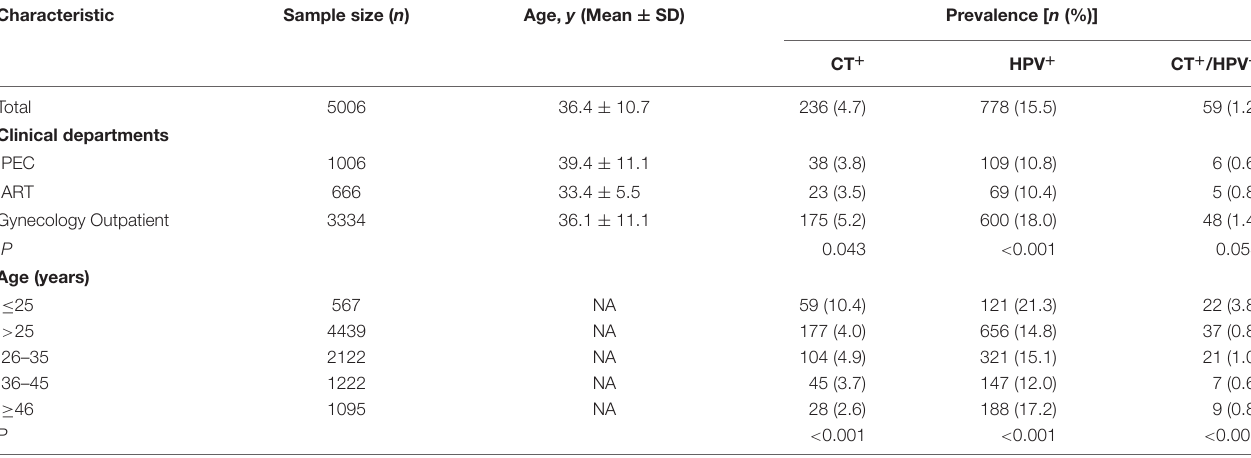
TABLE 1 | Prevalence of C. trachomatis and HPV infection of women in Southern Hunan province in China. Characteristic